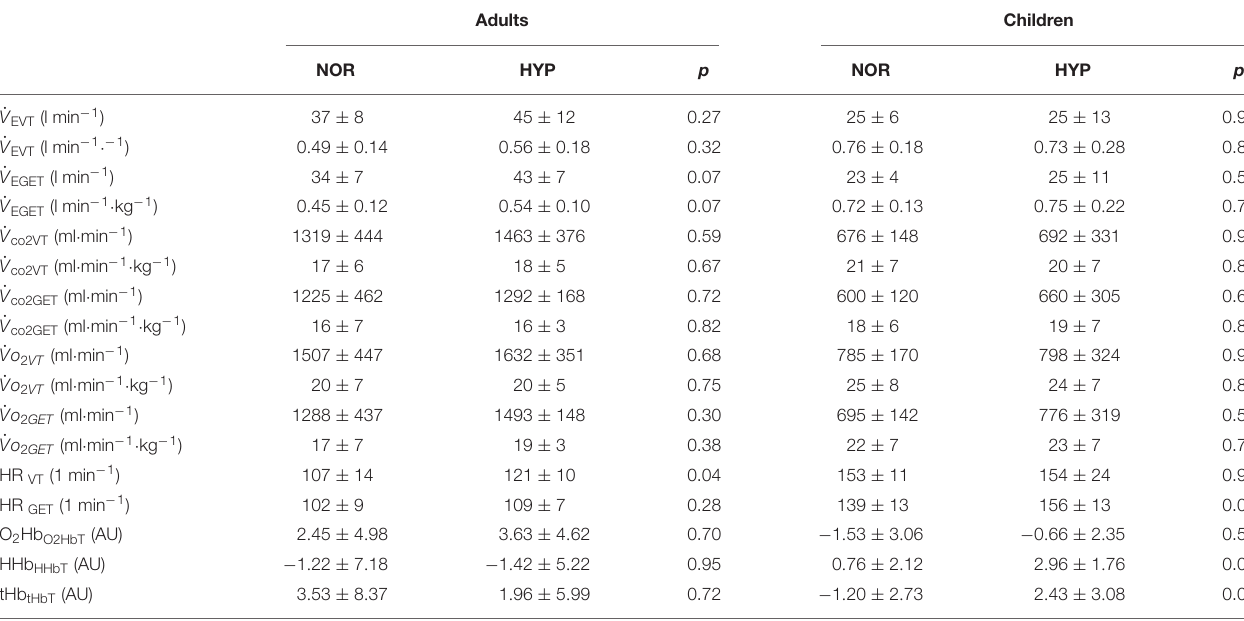
TABLE 3 | Values of ventilatory, gas exchange and muscle oxygenation thresholds during the graded cycling exercise test in adults and children.